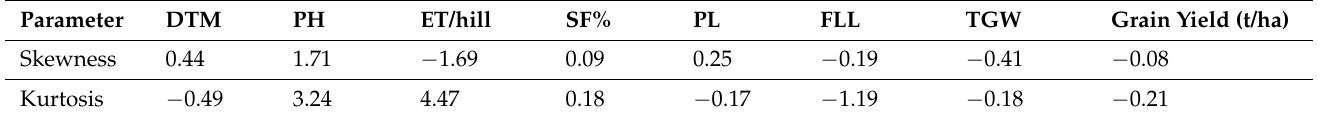
Table 1. Descriptive statistics of yield and yield-related traits in some hybrid combinations.